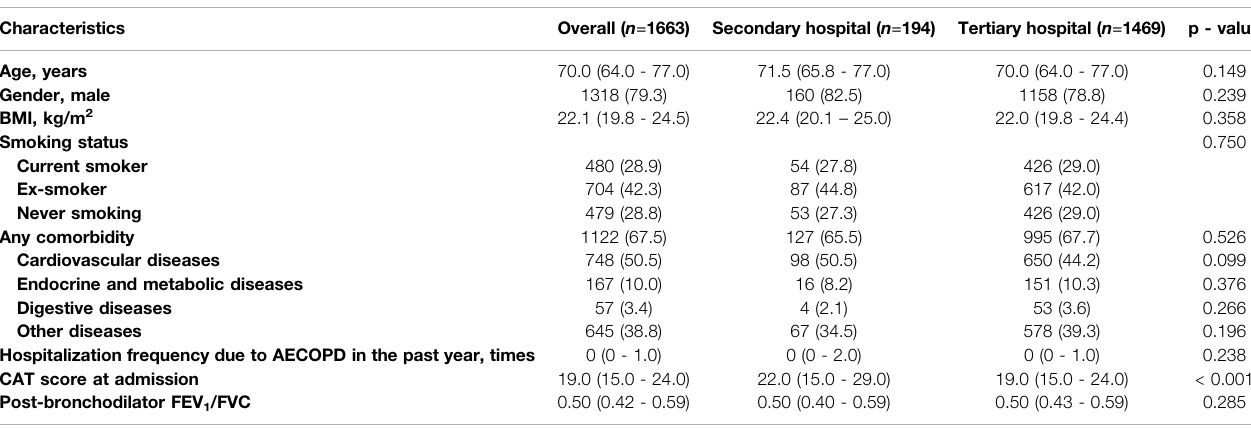
TABLE 1 | Baseline characteristics of included AECOPD patients.